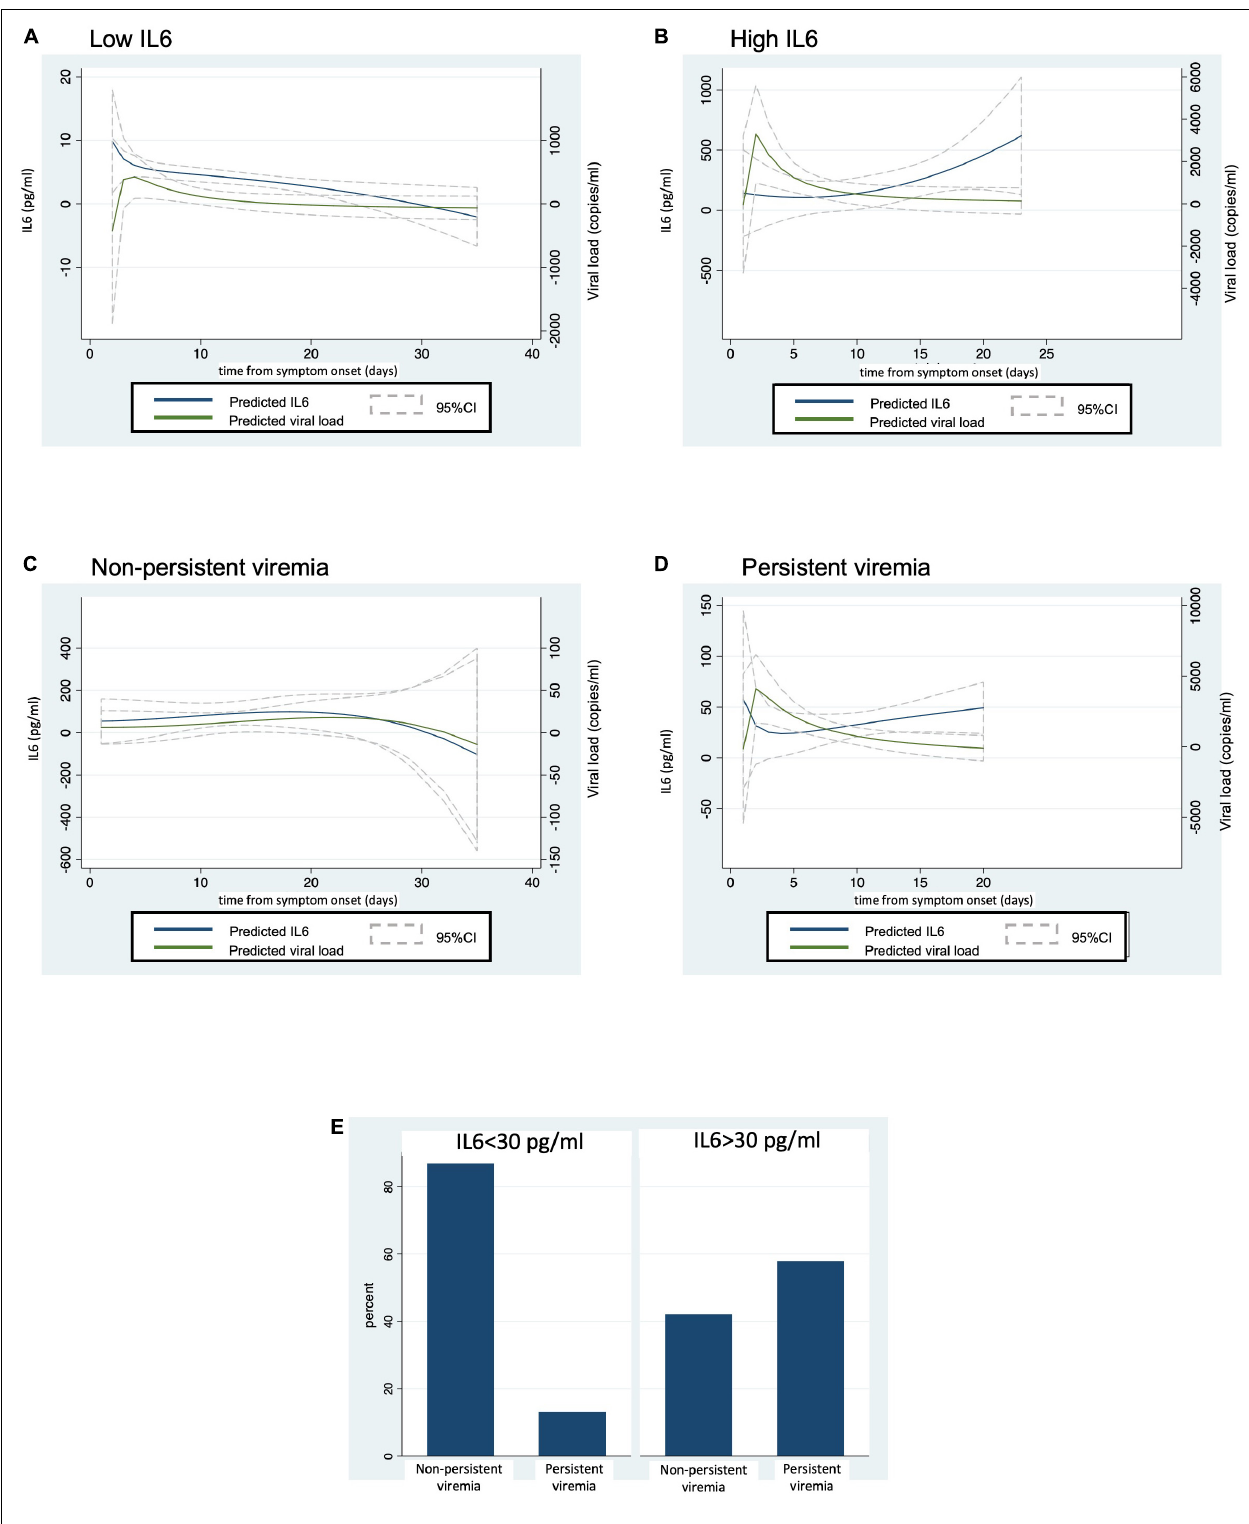
Frontiers in Medicine |